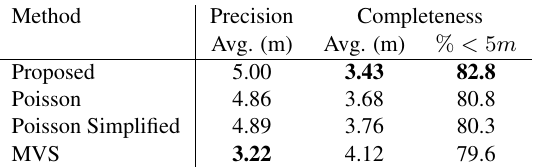
Figure 8. Quantitative results of the reconstruction. Top: Precision; Bottom: Completeness